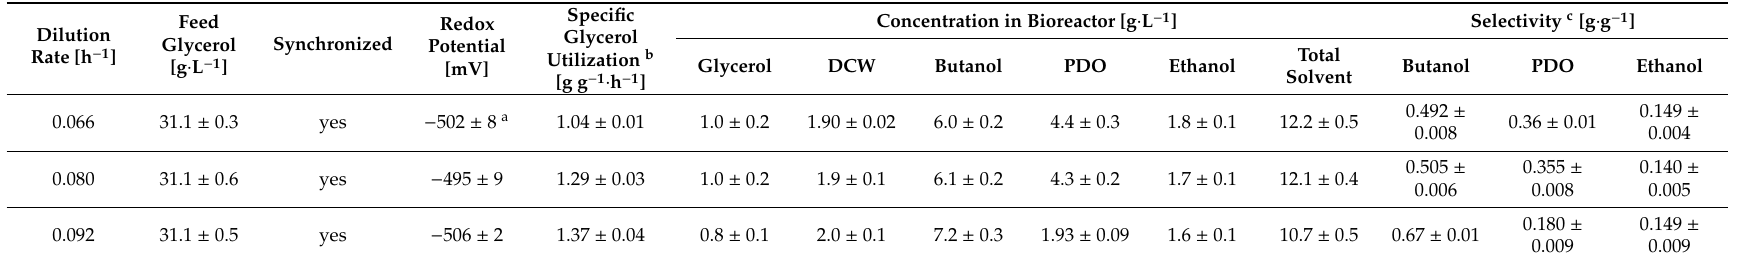
Table 2. Summary of average data for the investigation of the e ff ect of dilution rate on synchronized oscillatory metabolism at 35.5 ◦